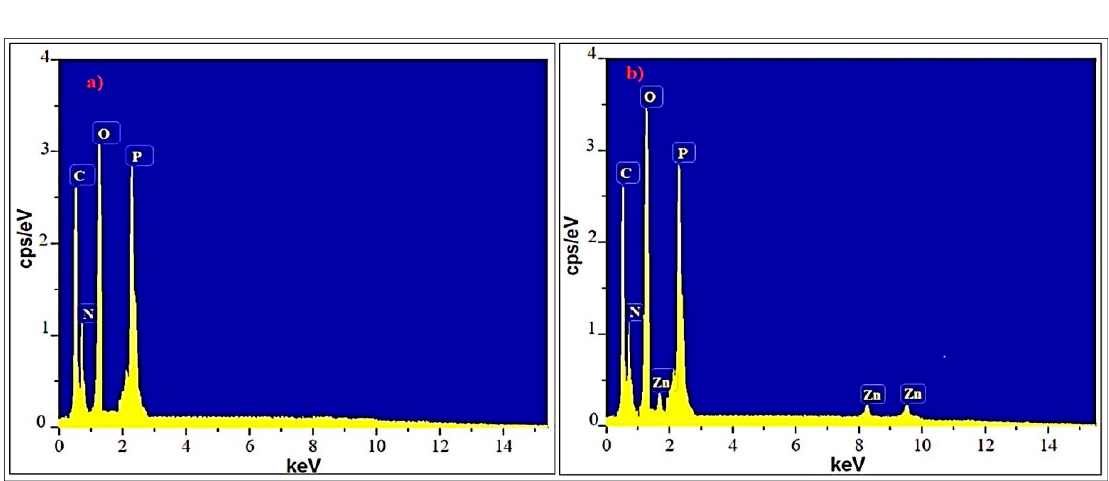
Figure 9. EDS spectra of formulation samples: ( a ) Ep/IFR and ( b ) Ep/IFR/ZnO-3%.